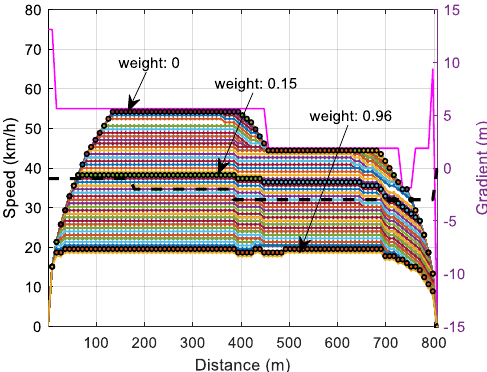
Table 6. Comparison of single-weight and multi-weight calculation results .